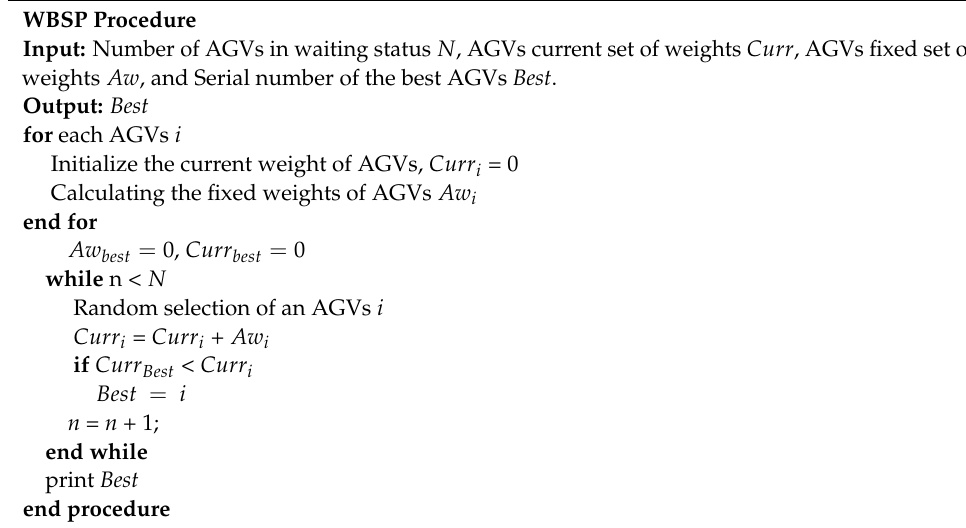
Algorithm 1 Weight-based smoothing polling